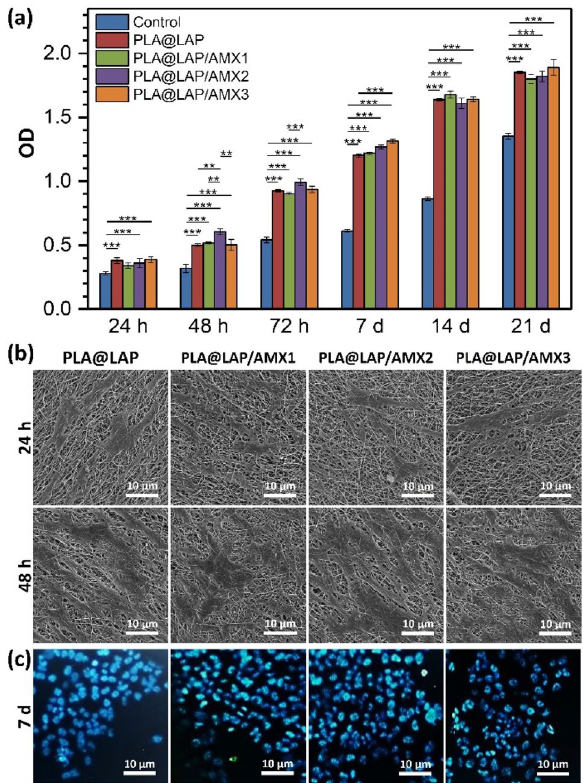
Figure 6. ( a ) Viability of hBMSCs cultured on scaffolds obtained from MTT assay (n = 3, * p < 0.05, ** p < 0.01, *** p < 0.001). A tissue culture plate was used as the control. ( b ) SEM images of hBMSCs cultured on scaffolds. ( c ) Fluorescent microscope images of the DAPI-stained hBMSCs cultured on